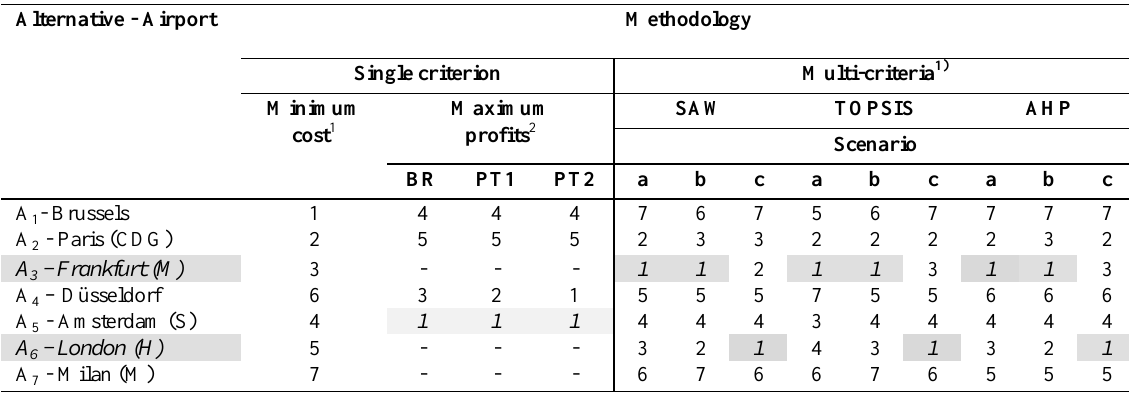
Table 6. Comparison of the results from different studies